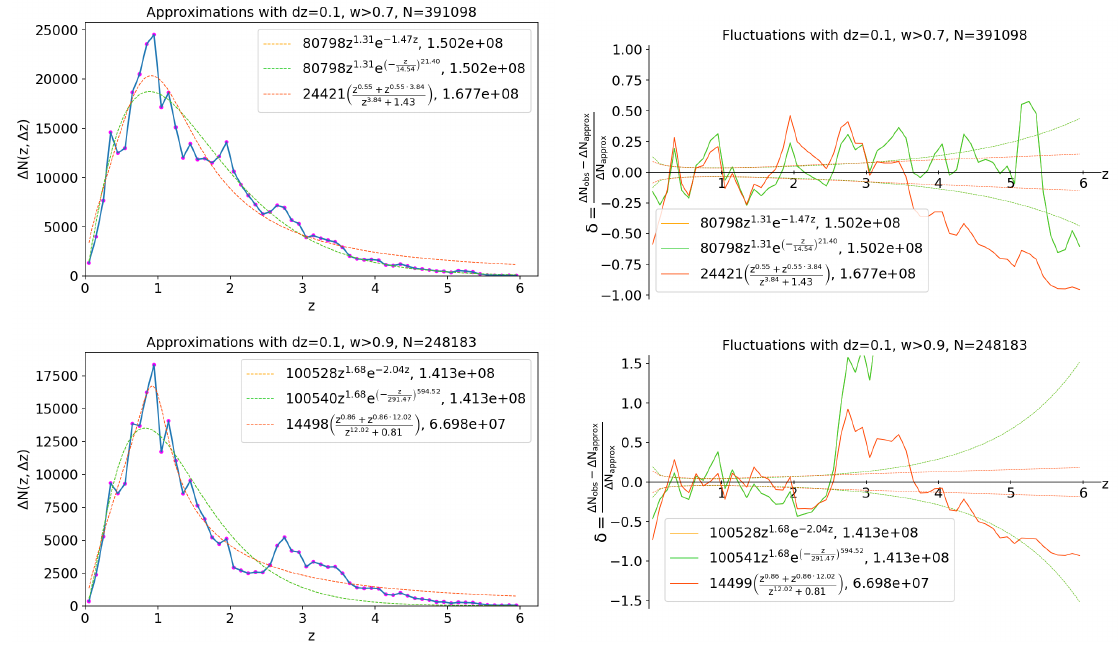
Figure 4. Histograms of radial distribution of the photometric redshifts and corresponding fluctuation patterns for samples with the parameter w = 0.7 for 391,098 galaxies ( top ), and w = 0.9 for 248,183 galaxies ( bottom ) with a bin ∆ z = 0.1. The dashed lines indicate the least squares fit ( left ) and Poisson noise 5 σ ( right ). Table 2. Tables of structures for w -samples from the COSMOS2015 catalogue for a bin ∆ z = 0.1 with z max = 6 and the various σ z selection. The approximation is by empirical Formula (6). In the last string there are the means of corresponding values (by all structures): mean of redshifts z mean , mean of structure sizes in Mpc R mean , mean of Poisson noise level 1 σ P , mean of observed cosmic variance σ mean , mean of dark matter variance σ dm , mean of dark matter bias b dm , mean of Peebles correlation function variance σ pl and its bias b pl (see details in the